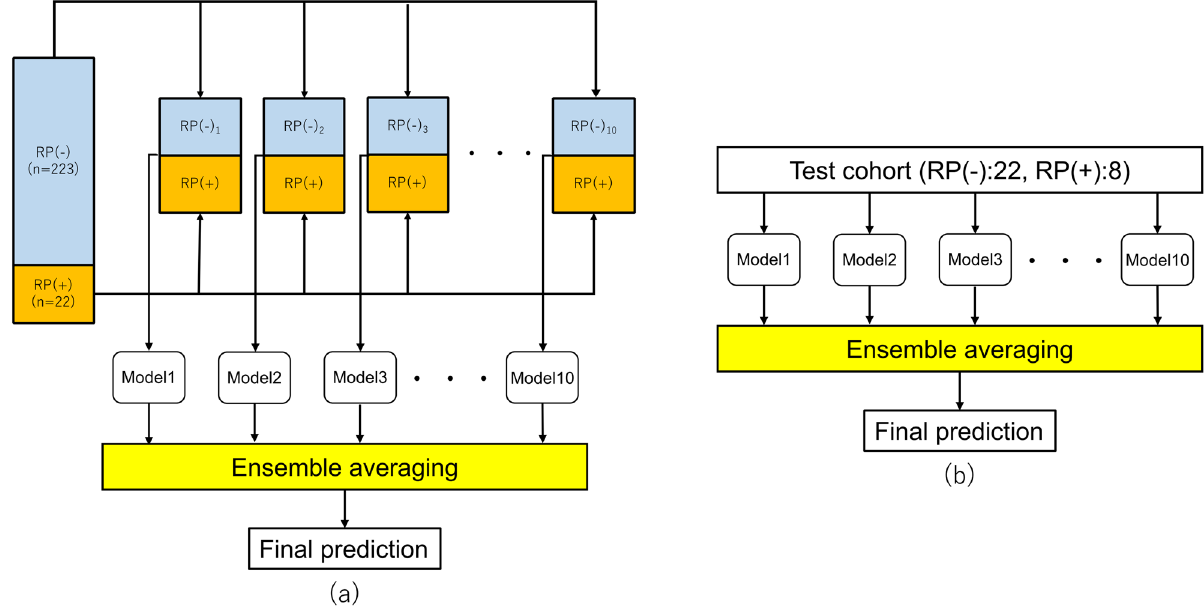
Figure 3. The concept of construction of an ensemble averaging model an imbalance adjustment strategy: ( a ) construction of an ensemble averaging model based on 10 subsets using a training cohort with 245 patients and ( b ) test of an ensemble averaging model using a test cohort with 30